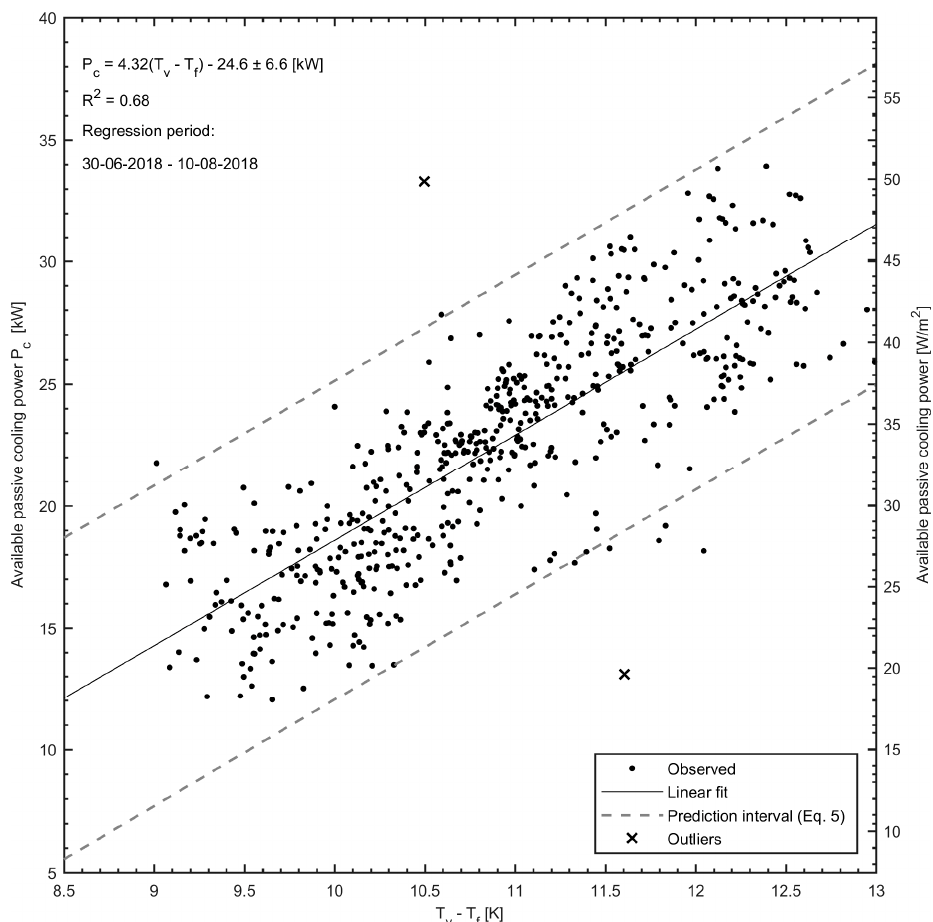
Figure 9. Linear, least square fit and simultaneous prediction intervals for the available cooling power P c (Equations (1) and (5)).